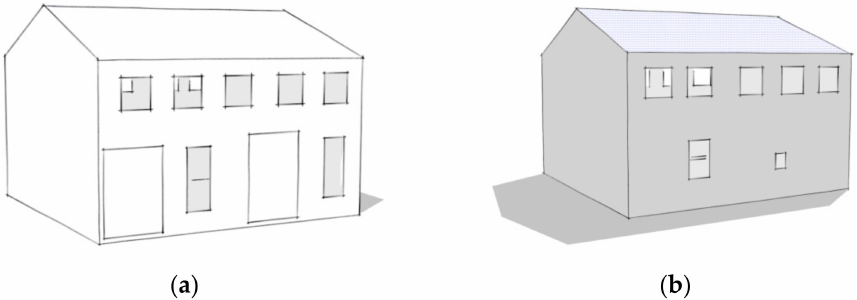
Figure 1. Model of the building built in Google SketchUp. Current state. ( a ) South and east façade ( b ) North and west